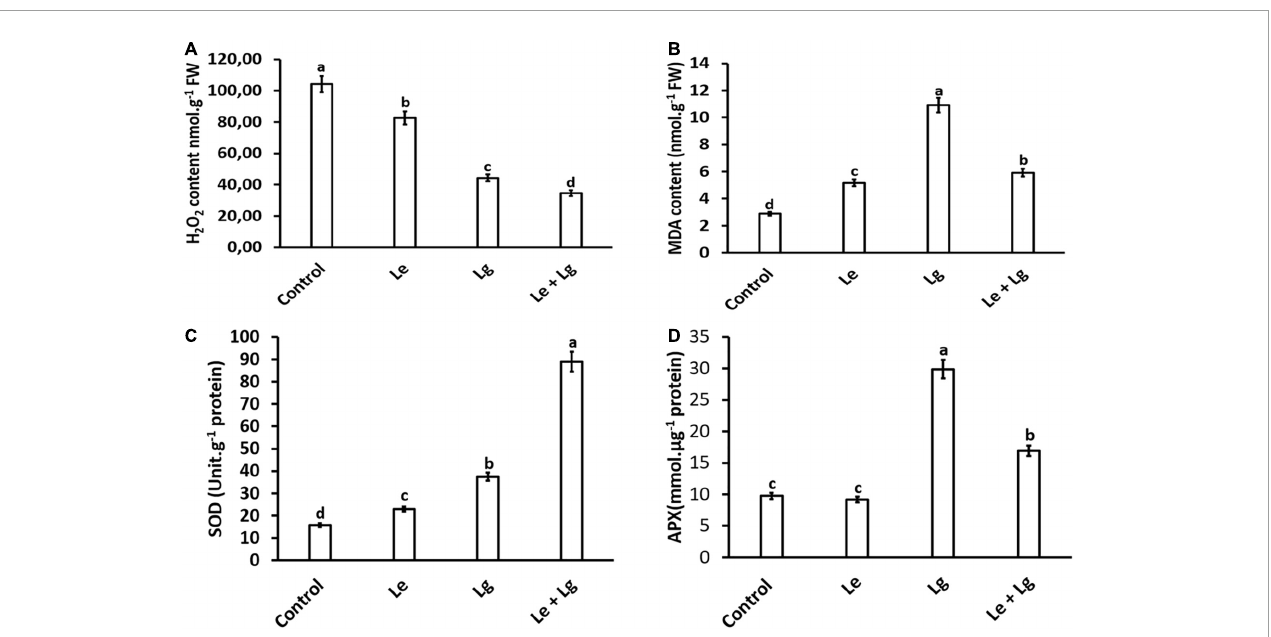
FIGURE1 Effect of essential oil singly and in combination on: (A) H 2 O 2 content – induced oxidative stress, (B) MDA content – lipid peroxidation, (C) SOD activity, and (D) APX enzyme activity in B. cinerea mycelia after 7-day-incubation. Values represent mean ( n = 9) ± standard error (S.E.). Various alphabets on the graphs indicate that the average mean values of different treatments are significantly different according to Tukey’s multiple comparison test at p ≤ 0.05 (Control, Le – Lemon, Lg – Lemongrass, and Le + Lg – combined effect of lemon and